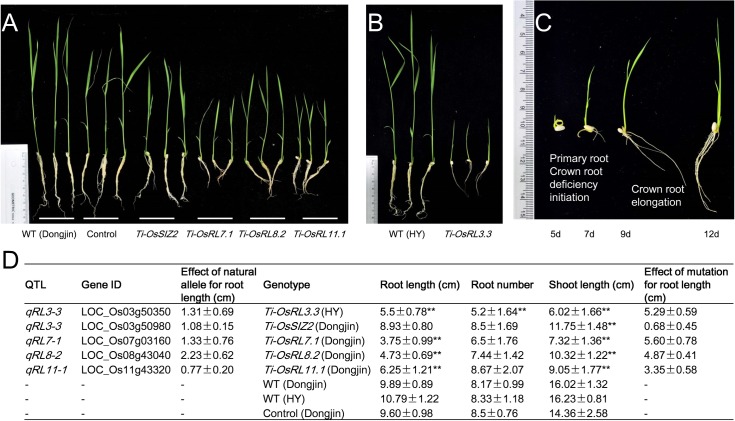
Validation of five QTL genes for root length by T-DNA insertion mutants.(A) Comparisons of root lengths of 12-day-old seedlings among the wild type (WT, Dongjin), control (mutant with a T-DNA insertion in HsfA4a) and T-DNA insertion mutant lines Ti-OsSIZ2, Ti-OsRL7.1, Ti-OsRL8.2 and Ti-OsRL11.1. (B) Comparisons of root lengths of 12-day-old seedlings among the wild type (WT, Hwayoung) and T-DNA insertion mutant line Ti-OsRL3.3. (C) The root morphologies of line Ti-OsRL3.3 at different growth stages. (D) Comparison of root lengths, root numbers and shoot lengths among the wild type, control and different T-DNA insertion lines at 12 days after germination. **, significant (P < 0.01) difference between the mutant line compared with WT and control.